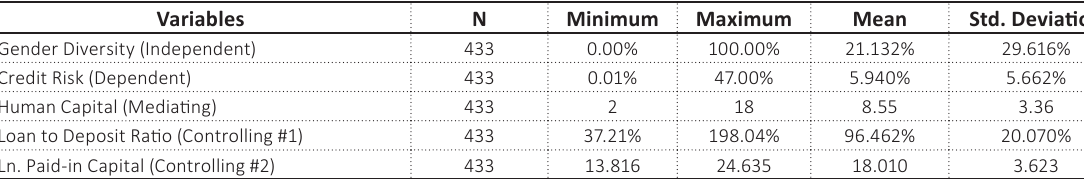
Table 2. Descriptive statistic